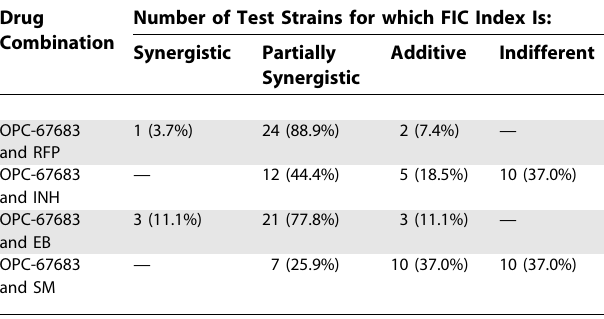
Table 4. In Vitro Synergistic Activity of OPC-67683 and Existing TB Drugs against Clinically Isolated M. tuberculosis Drug Number of Test Strains for which FIC Index Is: Combination Synergistic